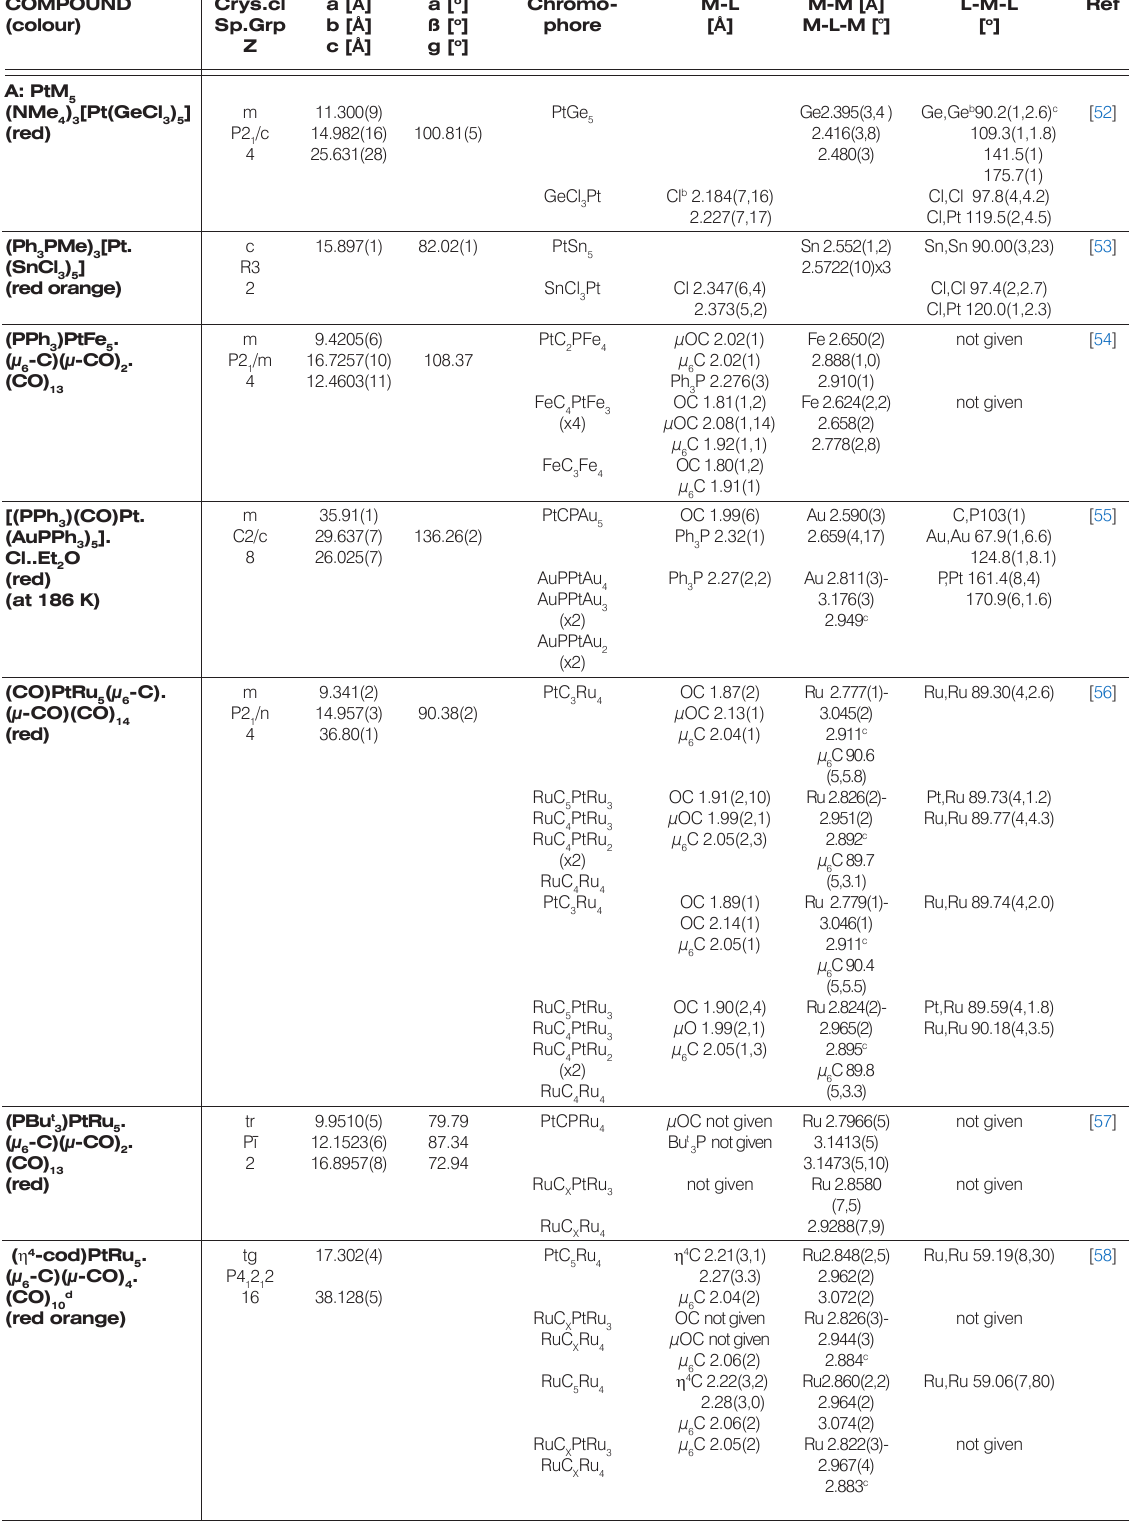
Table 3. Crystallographic and structural data for heterohexanuclear platinum clusters (PtM COMPOUND